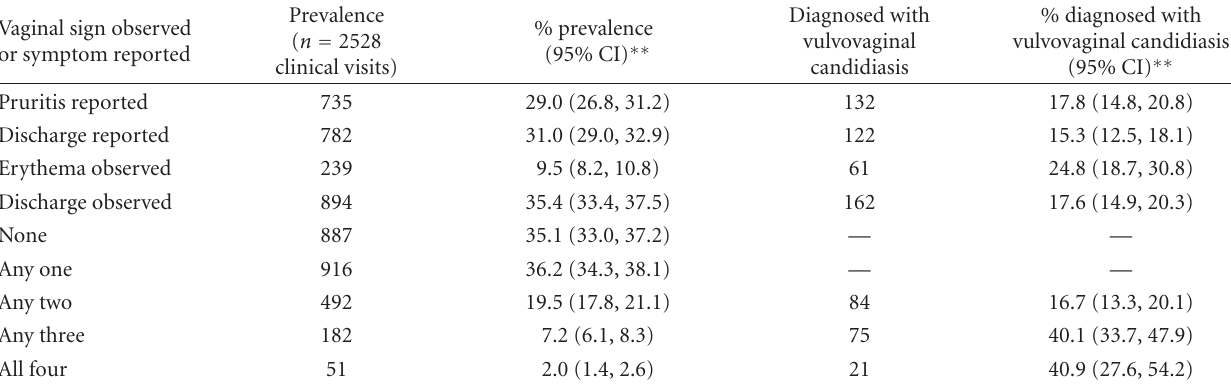
Table 2: Prevalence of observed clinical signs, reported symptoms, and diagnosis (positive predictive value) of vulvovaginal candidiasis, Mysore, India